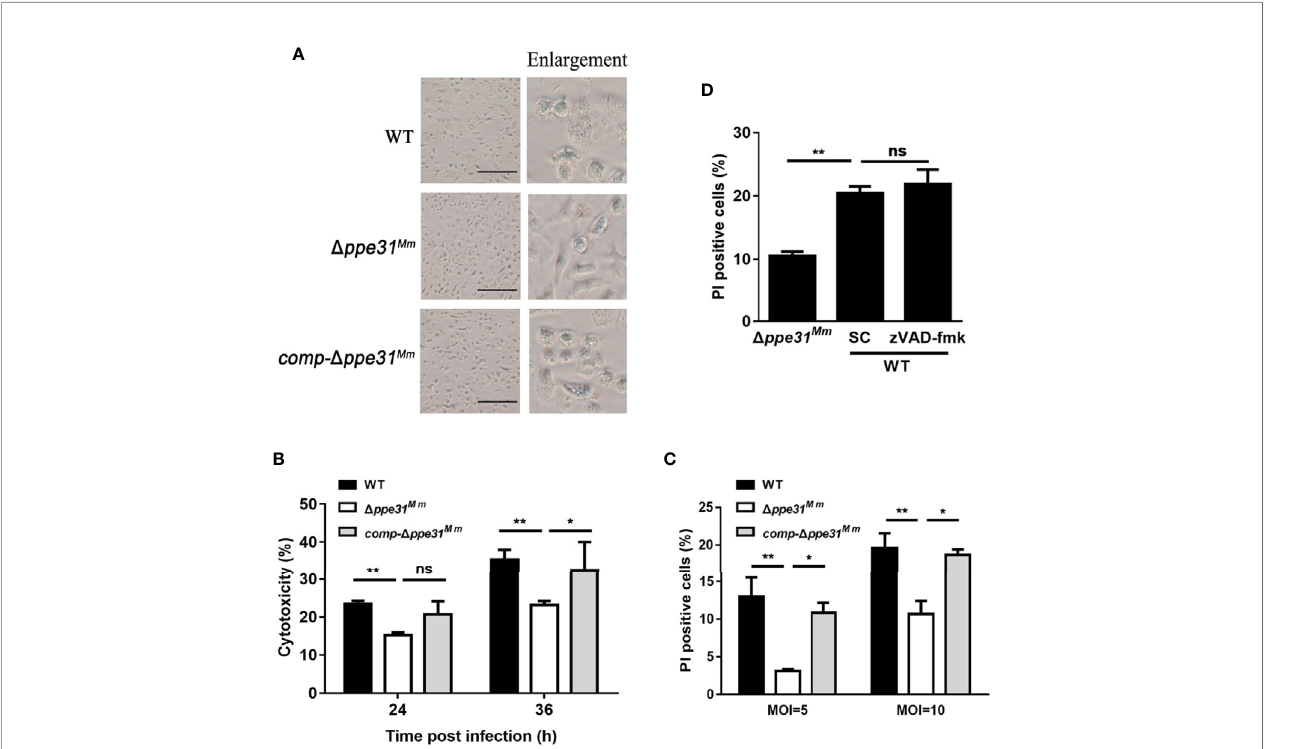
FIGURE 3 | Macrophages infected with D ppe31 Mm show reduced caspase- independent cell death. (A) BMDMs were infected with WT, D ppe31 Mm , or comp- D ppe31 Mm (MOI = 10) for 24h for analysis of morphological changes. Scale bar in 100 m m. (B) BMDMs were infected with WT, D ppe31 Mm , or comp- D ppe31 Mm (MOI = 10). The cytotoxicity was assessed by LDH release assay at indicated times. (C) BMDMs were infected with either WT, D ppe31 Mm , or comp- D ppe31 Mm (MOI = 10 or 5) for 24 h, and cell death was detected by PI staining and then examined by fl ow cytometry. (D) BMDMs were infected with WT, D ppe31 Mm or comp- D ppe31 Mm (MOI = 10) in the presence or absence of Z-VAD-FMK (20 m M), a caspase inhibitor, then cells were stained with PI and then examined by fl ow cytometry. Data are shown as mean±S.E.M. of three independent experiments. * p < 0.05, ** p < 0.01. WT, wild-type M. marinum ; UI, uninfected; SC, solvent control (0.1% DMSO); ns, no signi fi